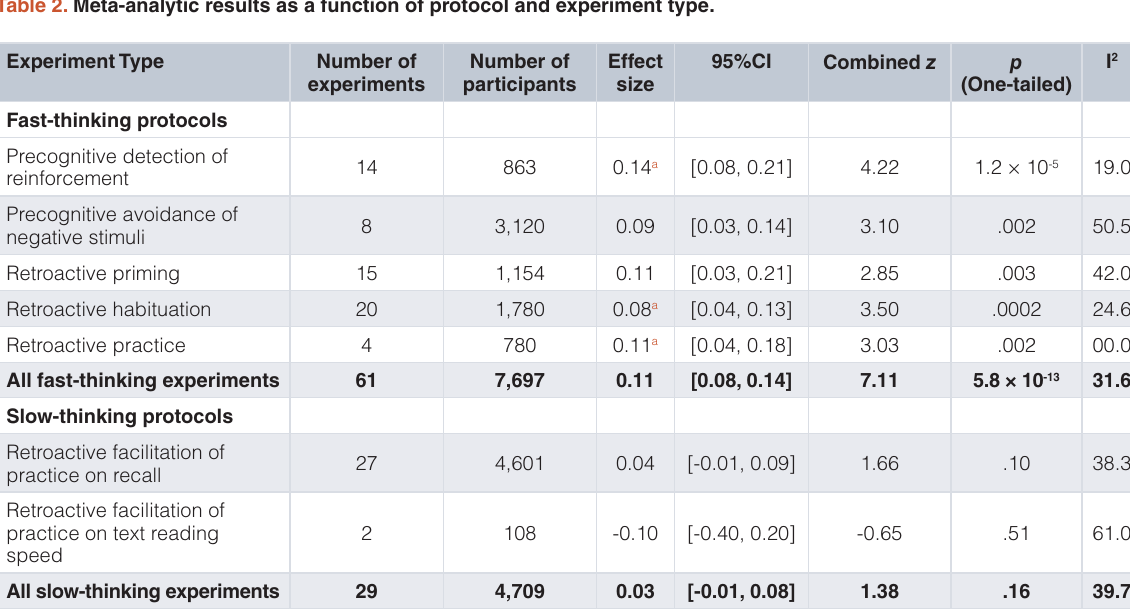
Table 2. Meta-analytic results as a function of protocol and experiment